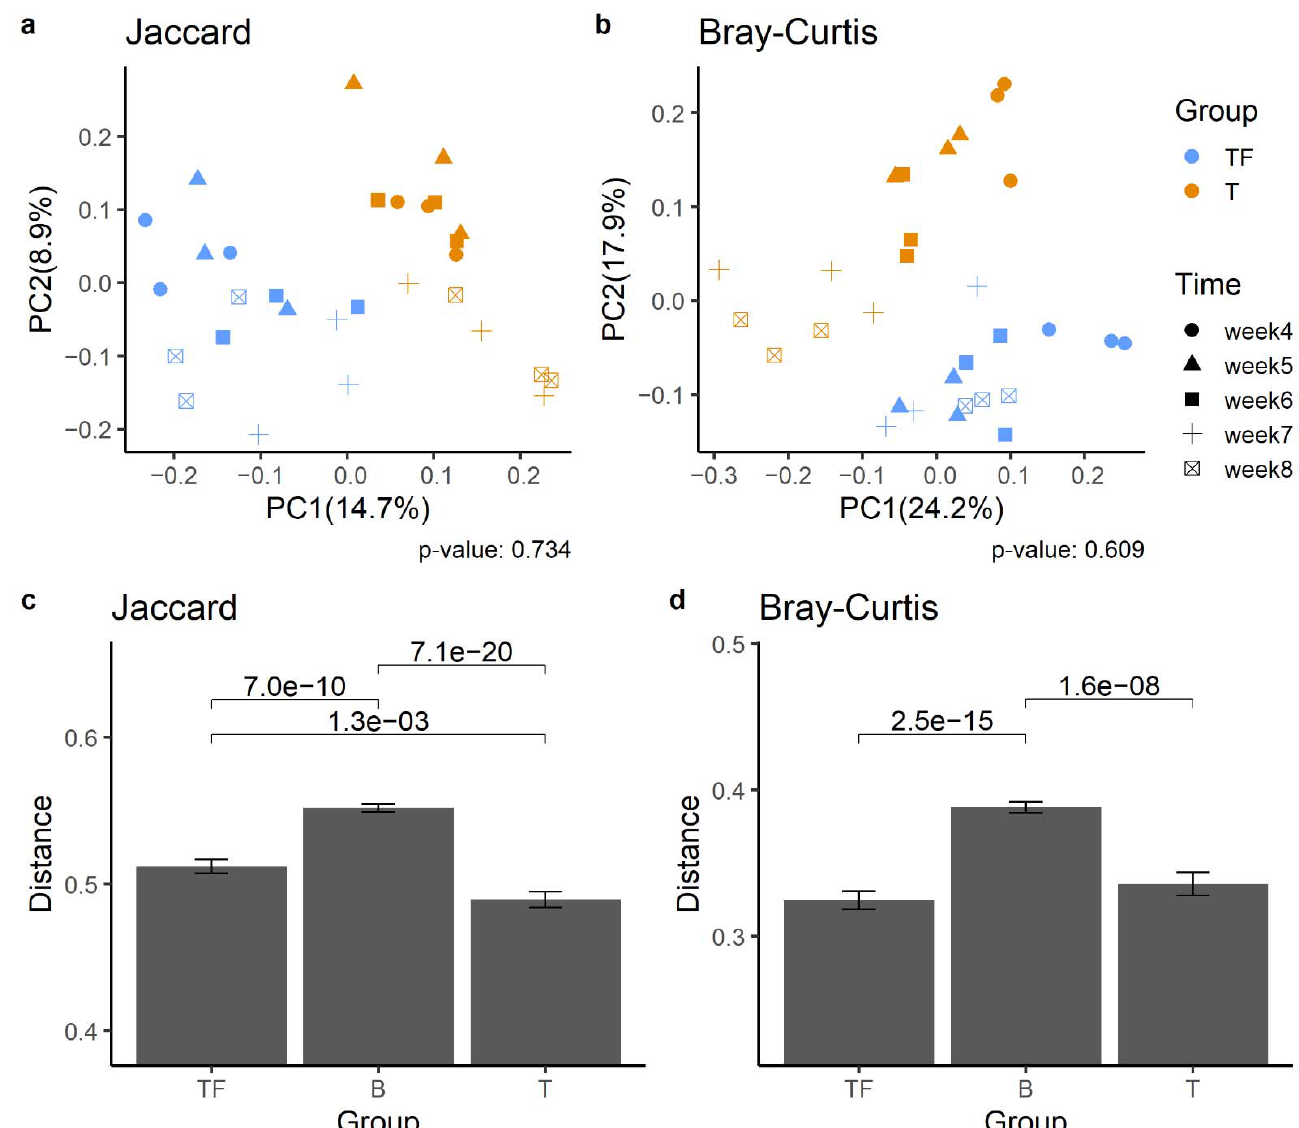
Figure 4. Beta diversity analysis of gut microbiota from T and TF groups. PCoA plots derived from ( a ) Jaccard distances and ( b ) Bray–Curtis distances show the separation of the two groups. The percentage of variation explained in PCoA plots is noted in parentheses at the x and y axes. The distribution of Jaccard ( c ) and Bray–Curtis ( d ) beta-diversity distances within and between T and TF groups reveal significantly different microbiota compositions between the two groups. The distances within TF and T groups are noted as TF and T, respectively, while the distance between TF and T groups is noted as B. p values derived from Wilcoxon rank-sum test are shown above the